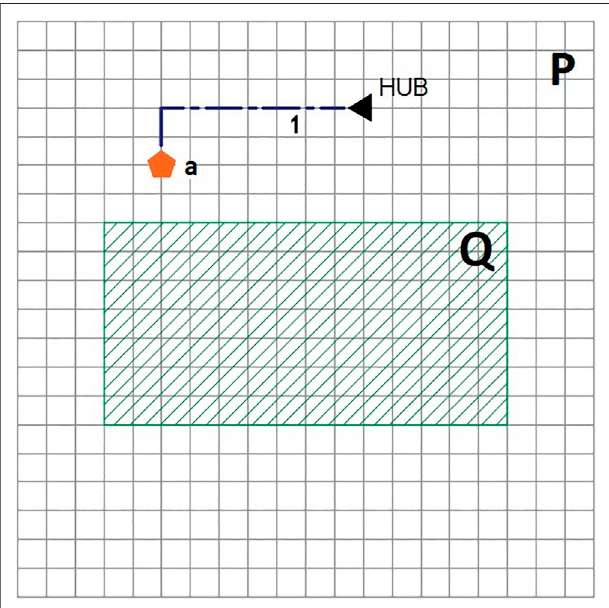
FIGURE 1 | Case 1: Customer a located in low-intensity Zone P .